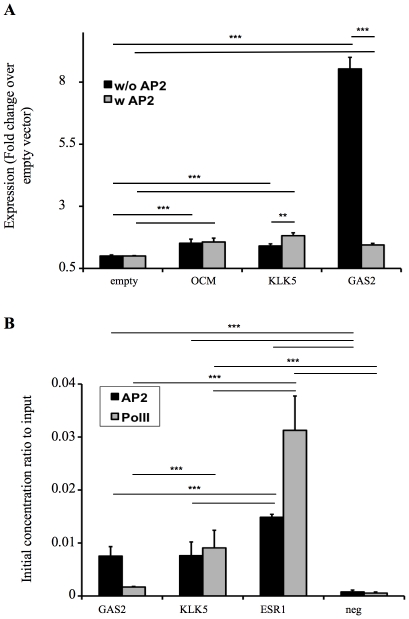
Functional validation of AP2α binding sites selected from PBM and weight matrix-based predictions.A) Genomic sequences corresponding to the OCM and GAS2 genes were selected on the basis of low and high binding potential, respectively, from the PBM dataset, while the KLK5 sequence was selected as an AP2α-bound promoter by weight matrix-based predictions with a score of 39 (medium affinity). SW480 cells were transiently co-transfected with reporter constructs containing these ∼900 bp regulatory sequences genomic sequences inserted upstream of a minimal promoter and eGFP sequence, and with either an AP2α expression vector or with the corresponding empty control vector. eGFP fluorescence was quantified by cytofluorometry. Graphs show the fold change of eGFP expression in absence or presence of AP2α as normalized to the fluorescence level obtained from the cotransfection of the eGFP reporter plasmids alone (n = 4, ***: p<0.001, **: p<0.005; two-tailed, two-sample equal variance t-test). B) ChIP-qPCR analysis of in vivo AP2α binding was performed using KM12C colon cancer cells that constitutively expresses AP2α [41]. The ∼900 bp sequences used in the eGFP reporter assay of panel A where searched for AP2α binding motifs utilizing the prediction weight matrix shown in Fig. S2, and qPCR primers were designed for the quantification of the assigned regions. A known AP2α binding site on the Estrogen Receptor 1 gene (ESR1) promoter serves as positive control, while an intergenic sequence upstream of the KLK5 gene was used as negative control. The abundance of RNA polymerase II indicates promoter occupancy by the transcriptional machinery. The initial concentration ratio of IP sample to sample Input were calculated as previously described [71]. Values obtained from the immunoprecipitated samples were multiplied by a factor of 100 before plotting.